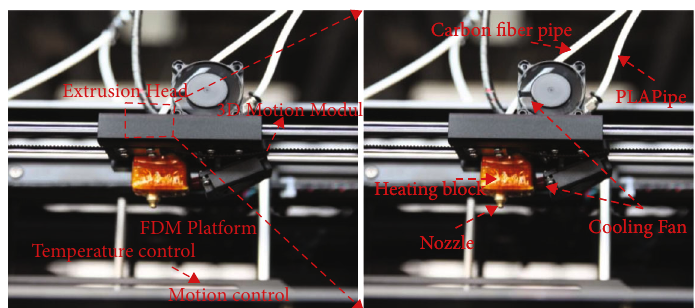
Figure 1: 3D printer used to prepare the continuous fi ber reinforced thermoplastic composites.